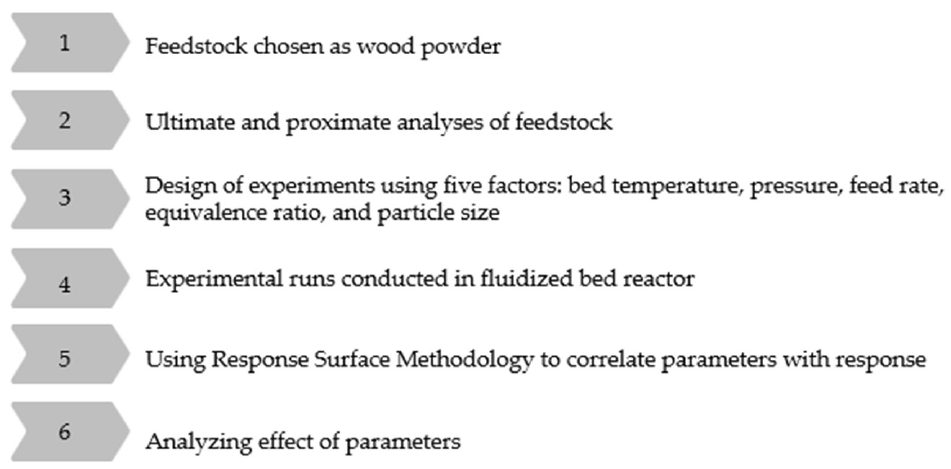
Figure 3. Systematic experimental and modelling approach for biomass gasification optimization.